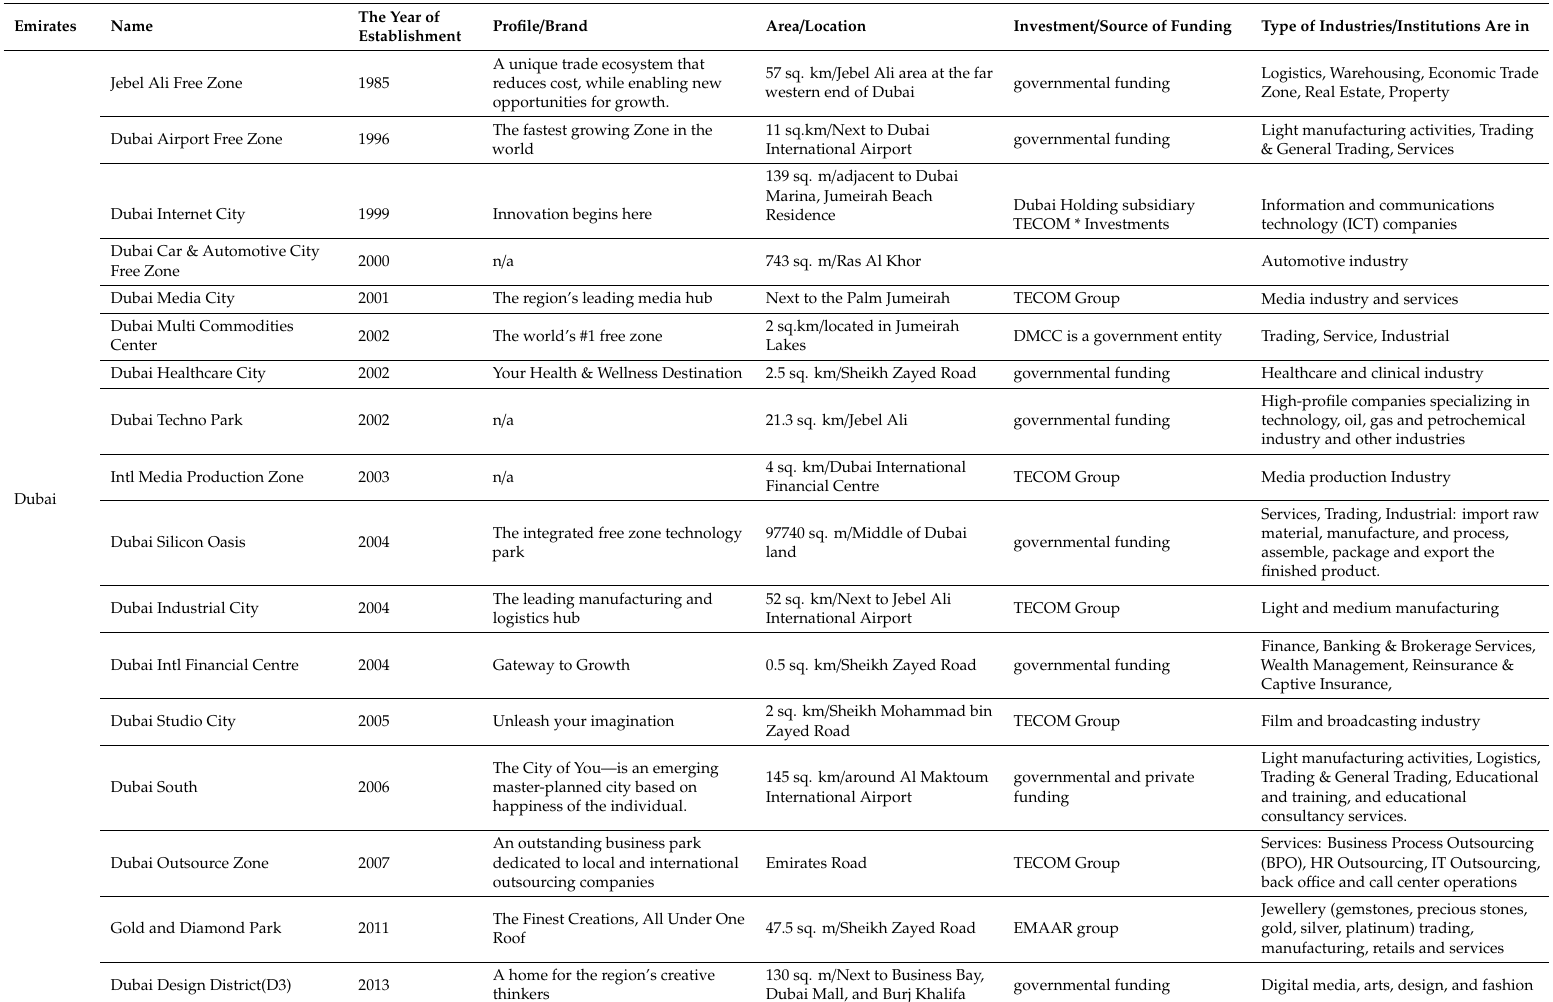
Table 2. Free economic zones and their main features in Qatar, Abu Dhabi and